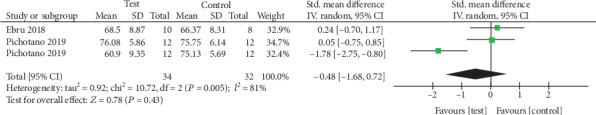
The implant stability quotient values (ISQ).